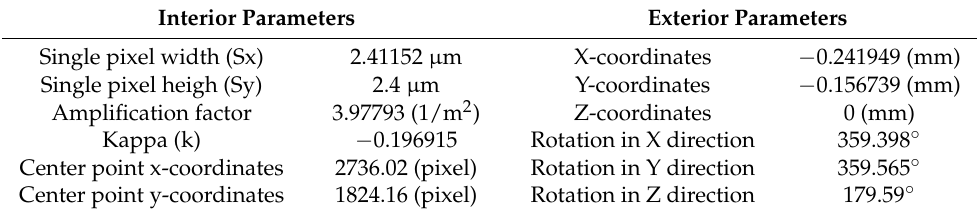
Table 2. Calibrated parameters of the left camera.